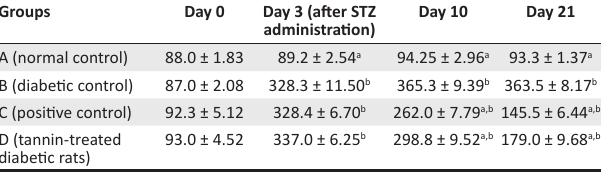
TABLE 3: Effects of tannins on blood glucose levels (mg/dL) of diabetic treated and control rats. Groups